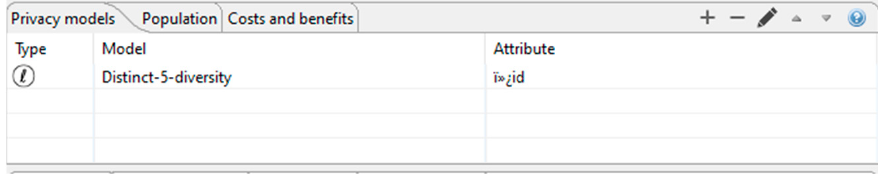
Figure 5. Privacy Model.